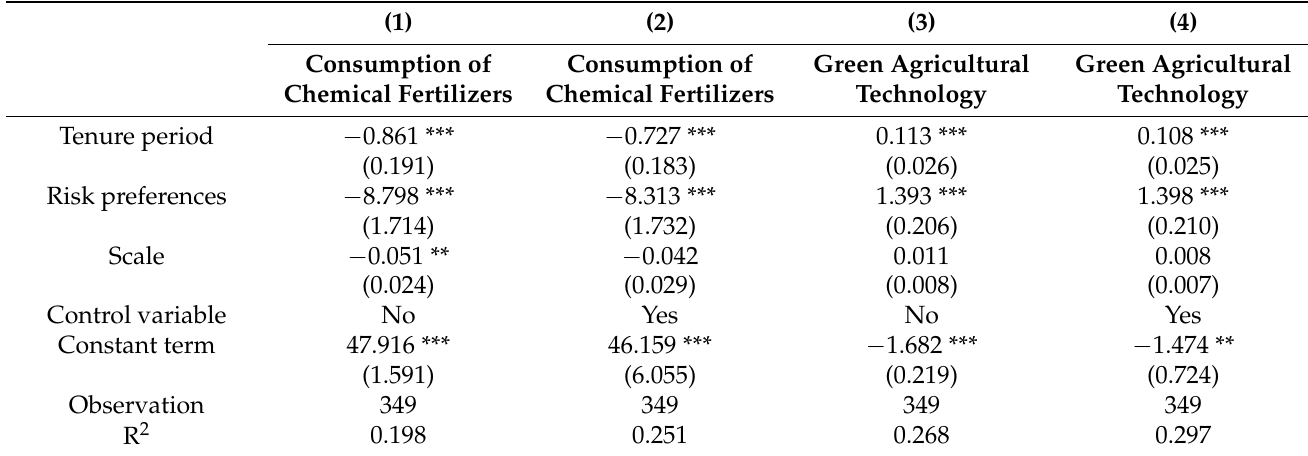
Table 7. Estimated results of land tenure duration and green production behavior of